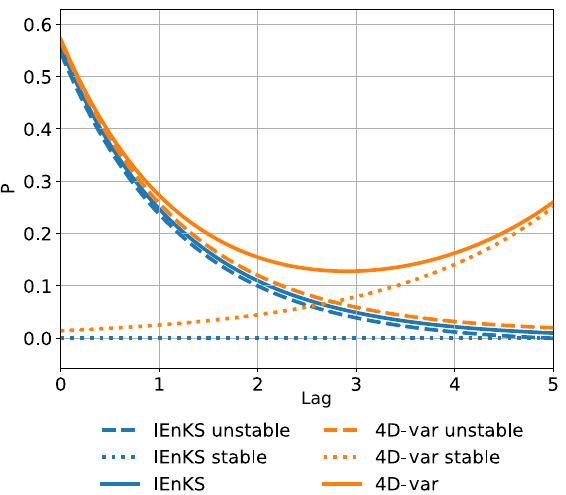
Figure 4. The asymptotic eMSEs as a function of the lag (lag = 0 is the filtering performance and lag = L is the smoothing perfor- mance). The superposing curves have been slightly translated for better readability, S = L = 5 , h = b = r =